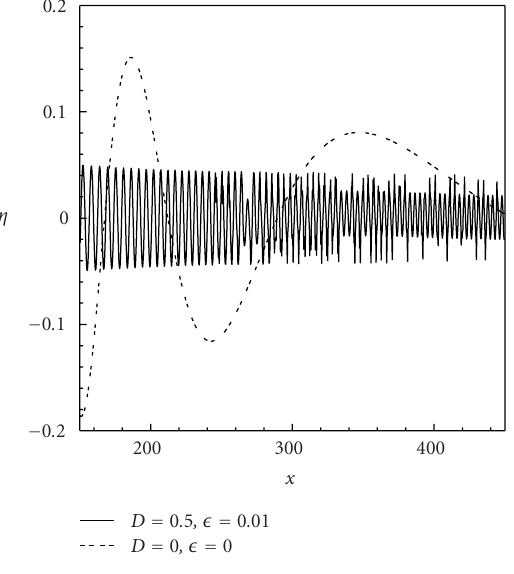
Figure 5.1. Wave motion due to initial displacement for fixed time t = 100; (cid:1) = 0 . 01, D = 0 . 5.